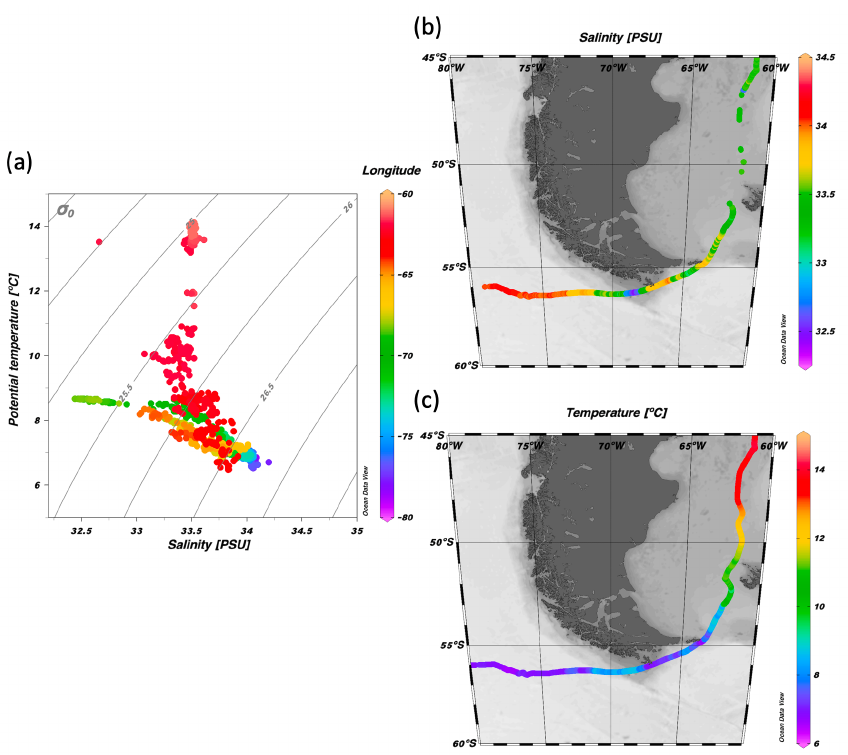
Figure 8. ( a ) Temperature − Salinity diagram using the filtered in-situ data along the South Patagonia- Cape Horn (colors indicate the longitude ( ◦ ) and contours represent the isopycnals σ θ ). ( b ) Salinity (psu) and ( c ) temperature ( ◦ C) recorded in the South Patagonia-Cape Horn